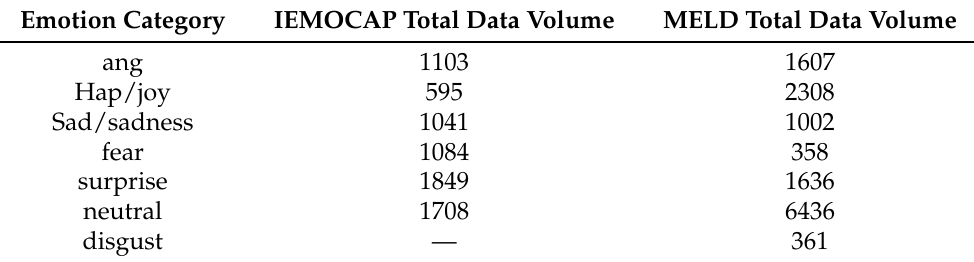
Table 1. IEMOCAP dataset and MELD dataset data